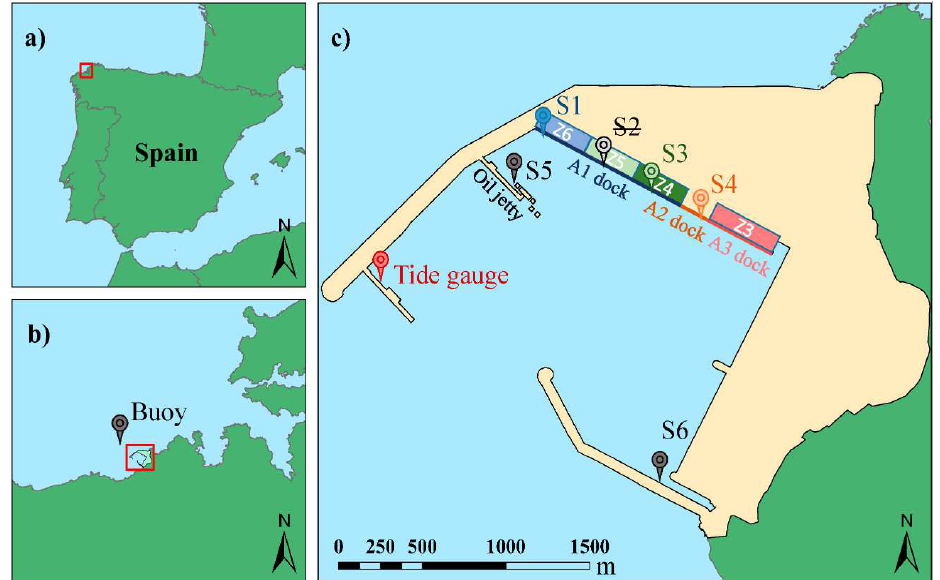
Figure 1. ( a ) Spain, showing the location of A Coruña, ( b ) situation of the port, buoy and zoom for section c, ( c ) plan view of the Outer Port of Punta Langosteira and position of pressure sensors (S1, S2, S3, S4, S5 and S6) and the tide gauge.